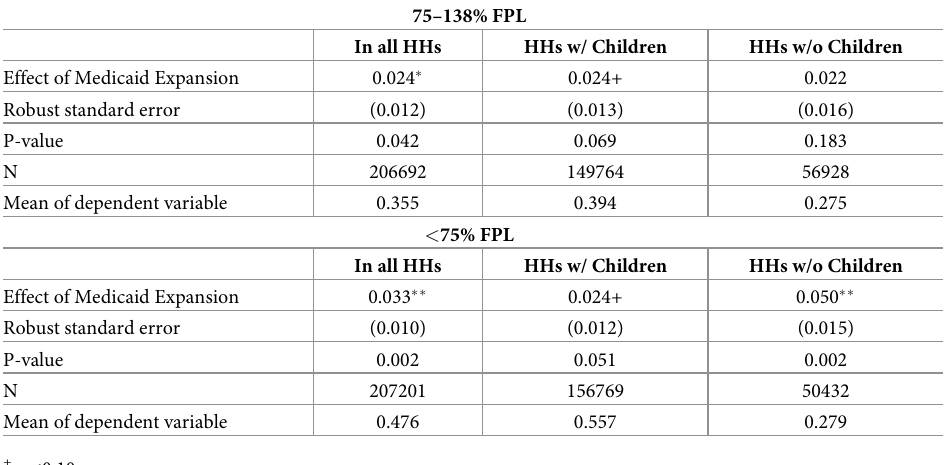
Table 2. ACA Medicaid expansion effects on SNAP receipt by household income and